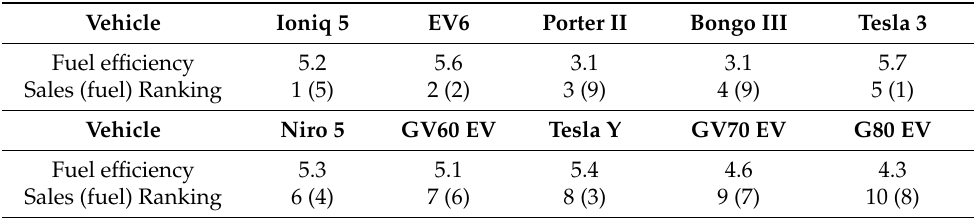
Table 5. Domestic electric vehicle sales rankings in South Korea (www.carisyou.com, January–August 2022) and the combined fuel efficiencies (km/kWh) (Government-approved compound fuel efficiency, South Korea, August 2022).